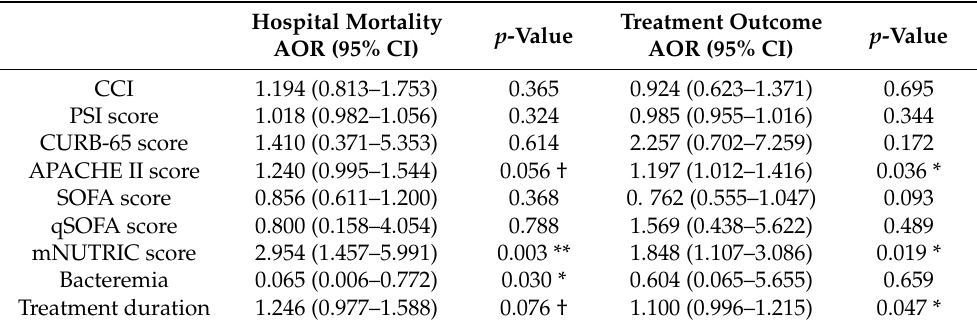
Table 6. Determination of predictors for clinical outcomes among 815 SCAP patients by multivariable logistic regression analysis.